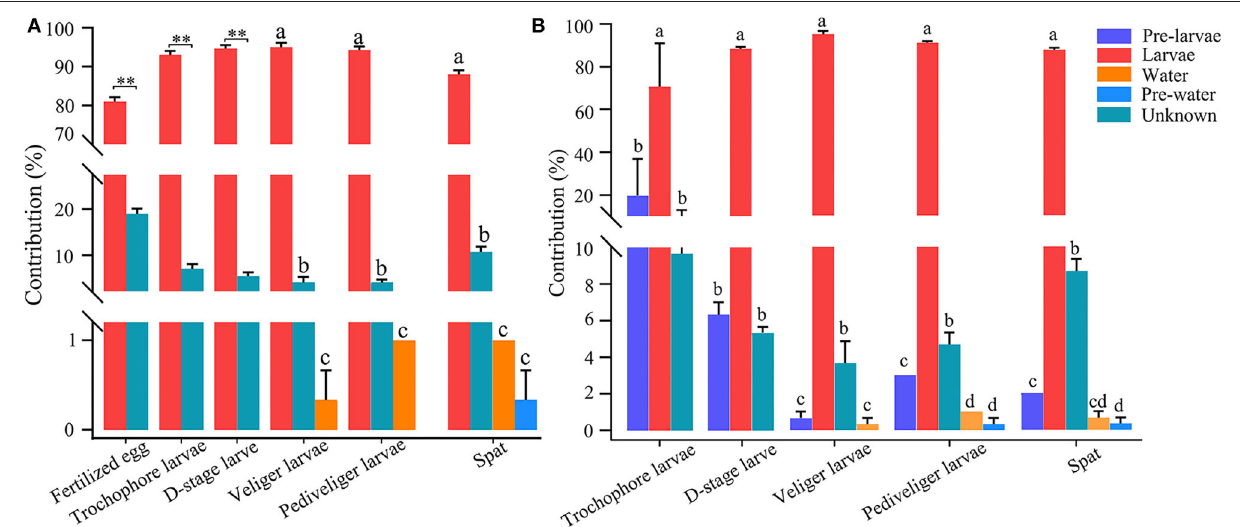
FIGURE 5 | SourceTracker analysis of the relative contributions of biotic sources to larval bacteria, when not introducing (A) and introducing (B) the larval bacteria at previous stage as another of internal sources. Different lowercase letters and asterisk (**) represent significant difference ( P < 0.05 and P < 0.01, respectively), among sources. Pre-larvae, larval bacteria at previous stage (i.e., larval bacteria at fertilized egg stage for trochophore larvae, larval bacteria at trochophore stage for D-stage larvae, larval bacteria at D-stage stage for veliger larvae, larval bacteria at veliger stage for prediveliger larvae, and larval bacteria at prediveliger stage for Spat); Larvae, larval bacteria at present stage; pre-water, rearing water bacterioplankton at previous stage (i.e., bacterioplankton at fertilized egg stage for trochophore larvae, bacterioplankton at trochophore stage for D-stage larvae, bacterioplankton at D-stage stage for veliger larvae, bacterioplankton at veliger stage for prediveliger larvae, and bacterioplankton at prediveliger stage for Spat); water, rearing water with bacterioplankton at present stage; unknown, unknown biotic